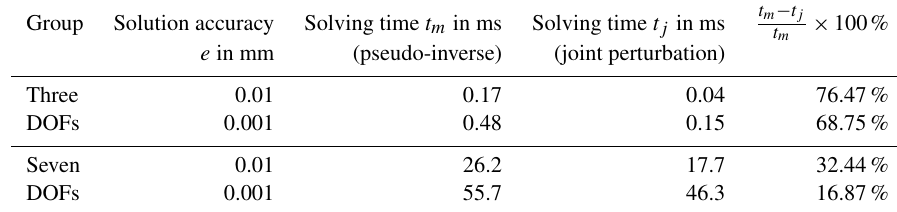
Table 6. Solving time for the Jacobian pseudo-inverse method and the perturbation